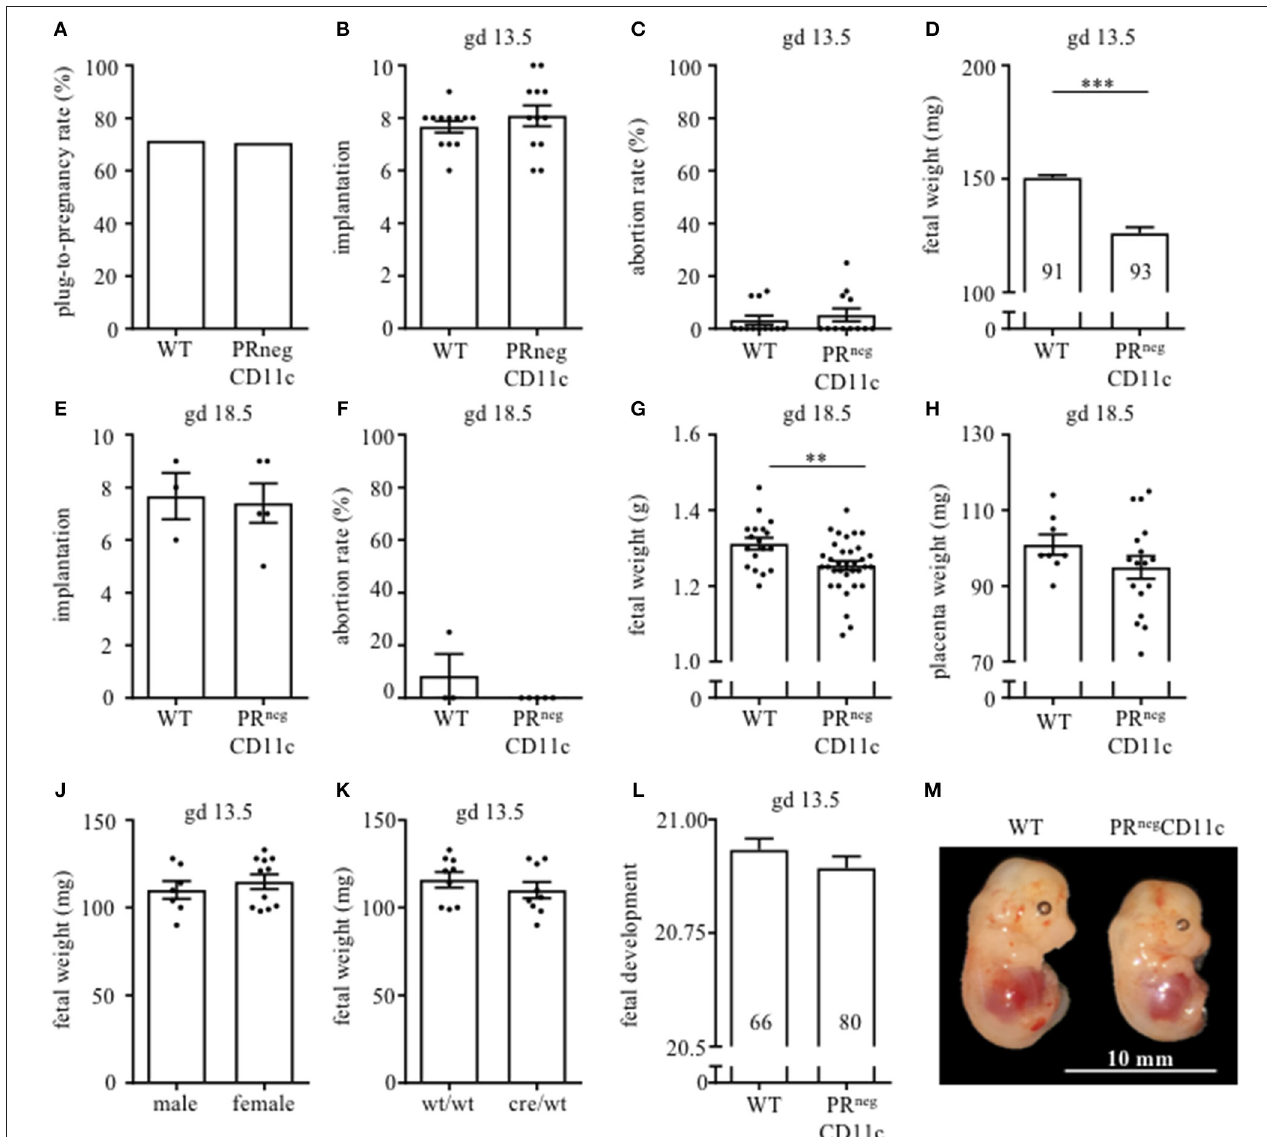
FIGURE 2 | Impaired progesterone-responsiveness of CD11c + dendritic cells affects fetal growth: WT and PR neg CD11c female mice were allogenically mated to Balb/c males and pregnancy outcome was assessed, maternal phenotype is always indicated below: (A) Plug-to-pregnancy rate. On gestational day (gd) 13.5, we assessed number implantation (B) , abortion rate (C) and fetal weight (D) . For gd 18.5, number implantation (E) , abortion rate (F) , fetal weight (G), and placental weight (H) were determined. Fetal weight of fetuses from PR neg CD11c dams is further shown dependent on fetal sex (J) and fetal genotype (K) . (L) Fetal development was scored on gd13.5 according to Theiler criteria and a representative picture from gd 13.5 fetuses of WT (left) and PR neg CD11c (right) mice is shown in (M) , white line in the picture denote 10mm. Data are represented as mean ± SEM. *** p ≤ 0.001, ** p ≤ 0.01.